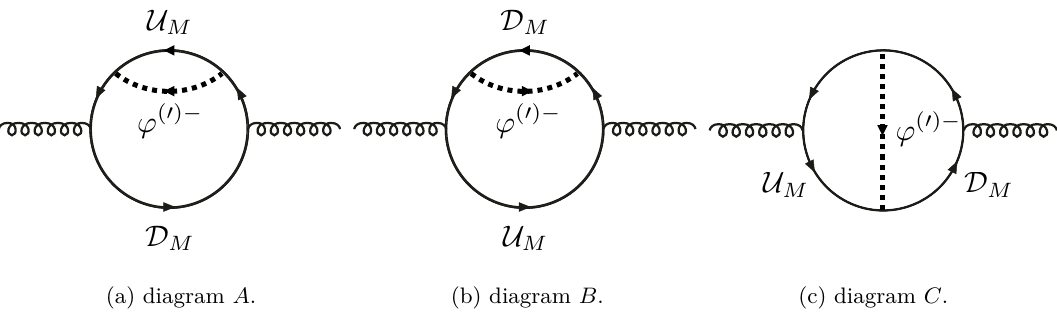
Figure 2. The charged NG boson contributions to the QCD ¯ θ term at two-loop